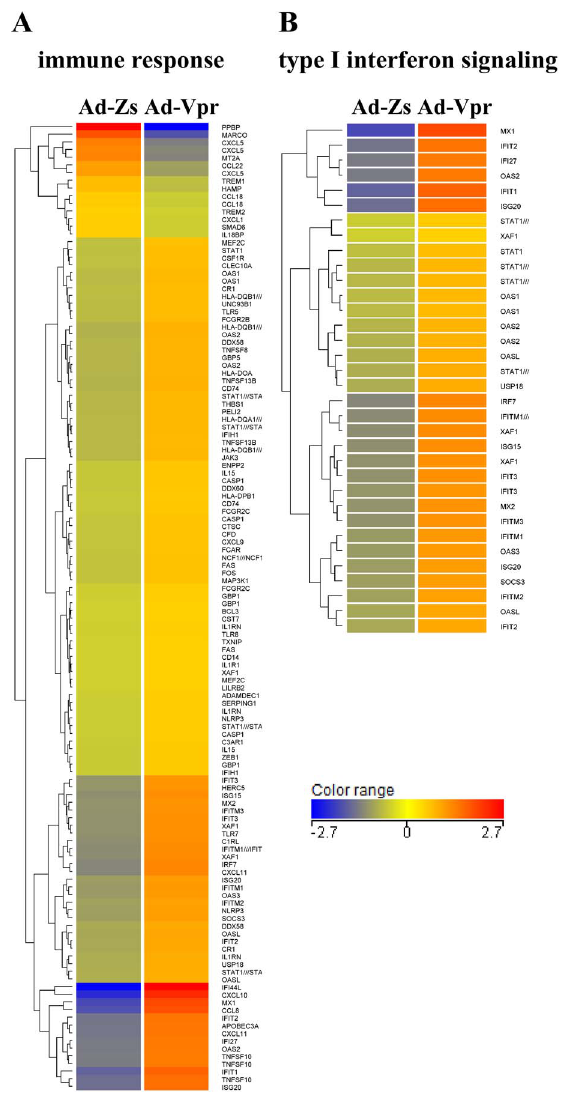
Figure 5. Differential expression profiling of cellular genes involved in the immune response and the type I interferon pathway after infection with Ad-Vpr in human monocyte- derived macrophages (MDMs) from Donor 1. Heat map showing genes related to the immune response (left: GO: 0006955) and the type I interferon signaling (right: GO: 0060337) that were either up- or down- regulated ( . 2-fold change) upon Ad-Vpr infection of MDMs from Donor 1. The color coding represents the normalized expression of genes in MDMs infected with Ad-Vpr or Ad-Zs (see color key). Gene up- regulation is denoted in red and gene down-regulation is denoted in blue.